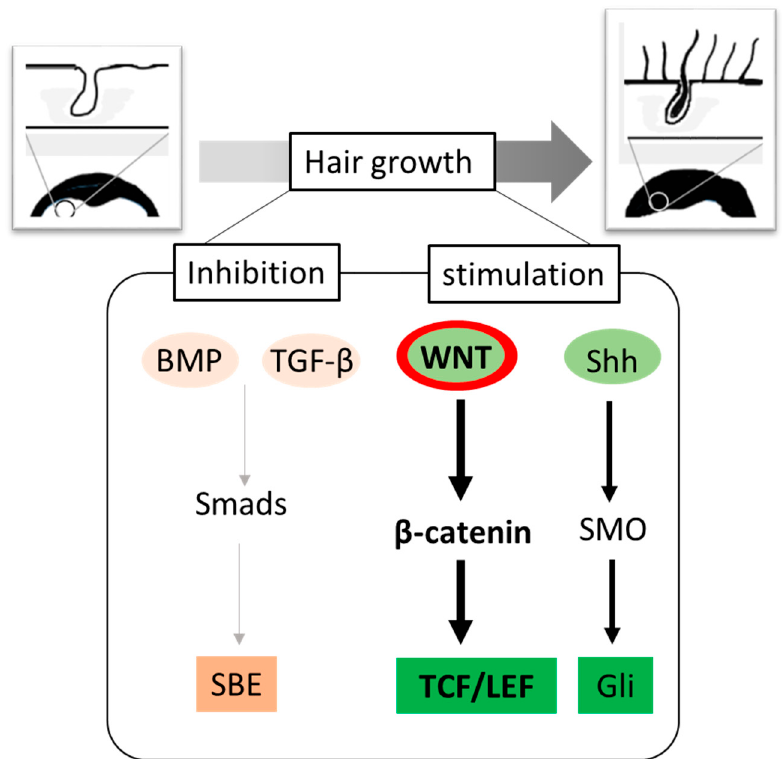
Figure 1. Molecular switches regulating hair growth. A variety of inter- and intracellular signaling molecules play critical roles in the formation of new hair. The negative regulators of hair growth include BMP and TGF- β signaling, whereas Wnt and Shh signaling activates anagen entry. The Wnt-mediated hair regrowth involves the stabilization of hypophosphorylated β -catenin, which interacts with TCF / LEF and translocates to nucleus to promote transactivation of growth promoting genes. Abbreviations: BMP, Bone morphogenetic proteins; TGF- β , Transforming growth factor- β ; Smad, homologs of the Drosophila protein, mothers against decapentaplegic (Mad) and the Caenorhabditis elegans protein Sma; SBE, Smad-binding element; Wnt, wg derived from the Drosophila gene wingless (wg) and int derived from the proto-oncogene integration-1; TCF / LEF, T-cell factor / lymphoid enhancer factor; Shh, Sonic hedgehog; SMO-smoothened; Gli, glioma-associated oncogene family zinc finger 1.